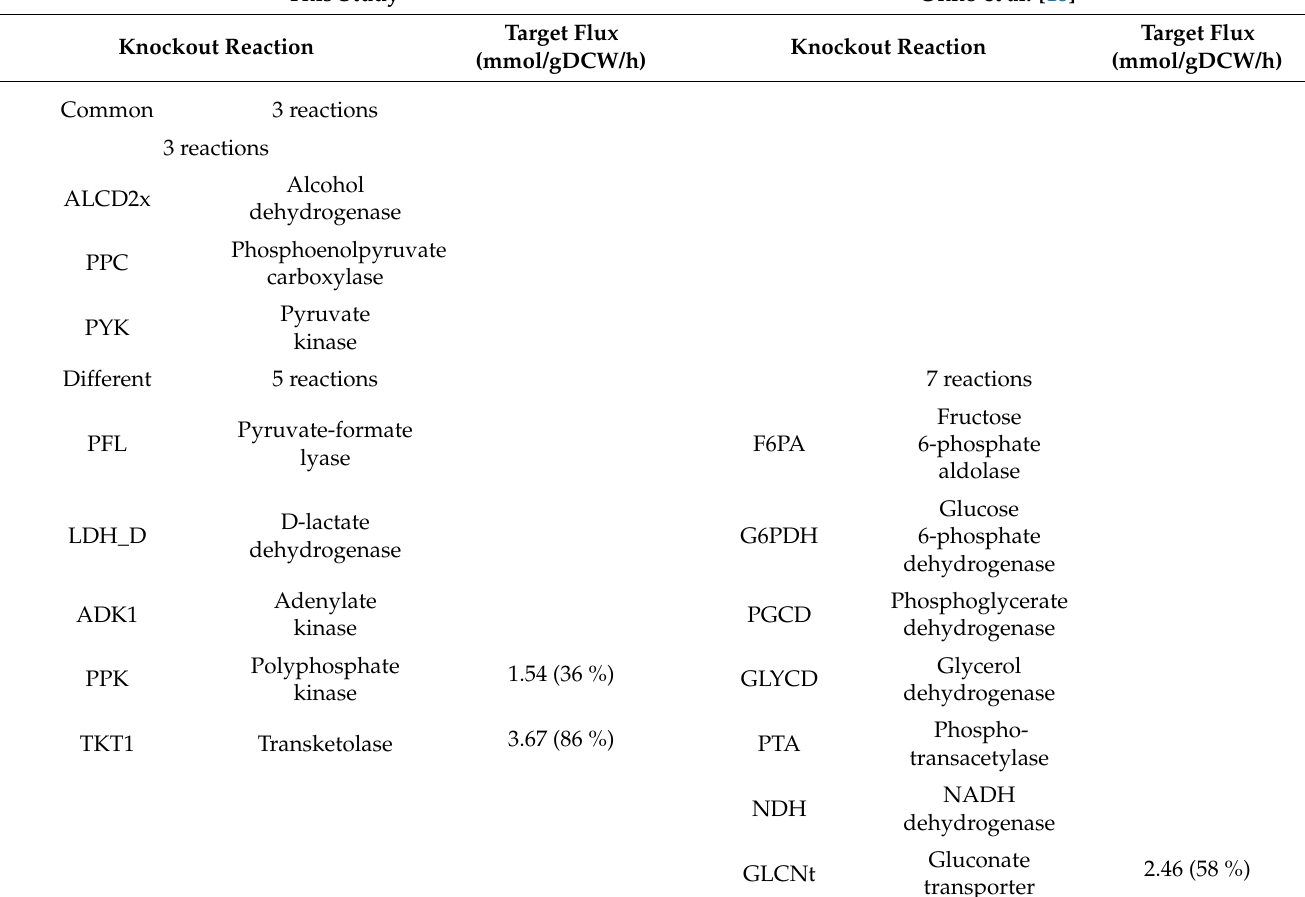
candidates; Table S2: Eighty-one compounds, their theoretical maximum production flux values, and their minimum oxygen uptake rate values; Table S3: A set of deletions that promoted target compound production were identified when the r value was decreased from 0.95 to 0.90; Table S4: A set of proposed reaction deletions for each of the 68 compounds that spontaneously produced the target compound while maintaining growth maximization conditions; Table S5: A list of the number of reactions to be deleted for the production of compounds; Table S6: Results of running AERITH for acetic acid and succinic acid production, respectively; Table S7: Comparison of the results of implementing AERITH and Optknock for the E. coli model iJR904 with an additional 1,4-butanediol synthetic pathway; Table S8: Comparison of the results of implementing AERITH and Optknock for the Synechocystis sp. PCC 6803 model iJN678 with a butanol biosynthesis pathway; Table S9: Comparison of the results of implementing AERITH and Optknock for 2,3-butanediol production using Saccharomyces cerevisiae model